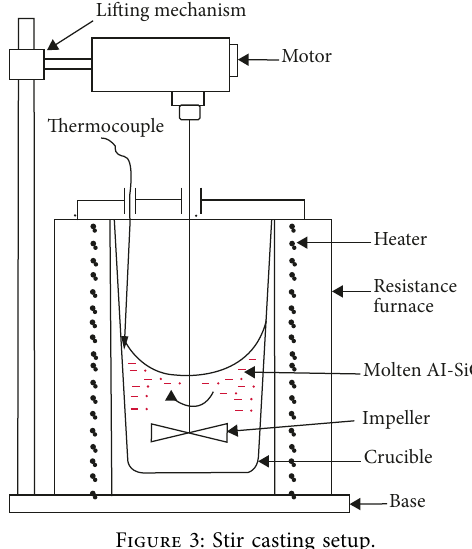
Figure 3: Stir casting